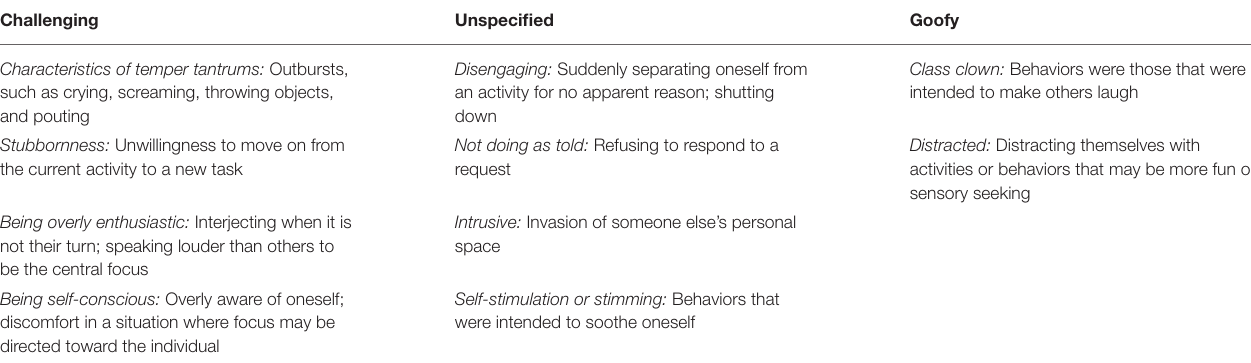
TABLE 3 | Categories of challenging and/or disruptive behaviors. Challenging Unspecified